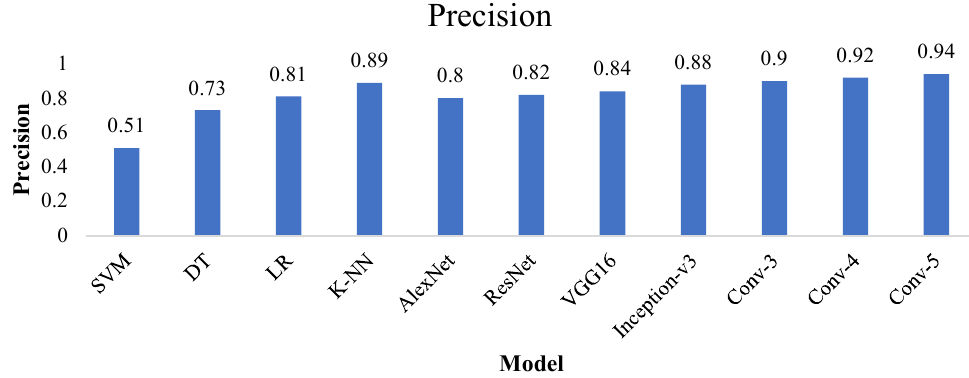
Figure 17. Testing accuracy of all the advanced and proposed techniques. Precision is defined as the ratio of correctly predicted values to the total predicted values. Figure 18 represents that the proposed Conv-5 DCNN model achieved a precision value of 0.94, much higher than the other techniques.